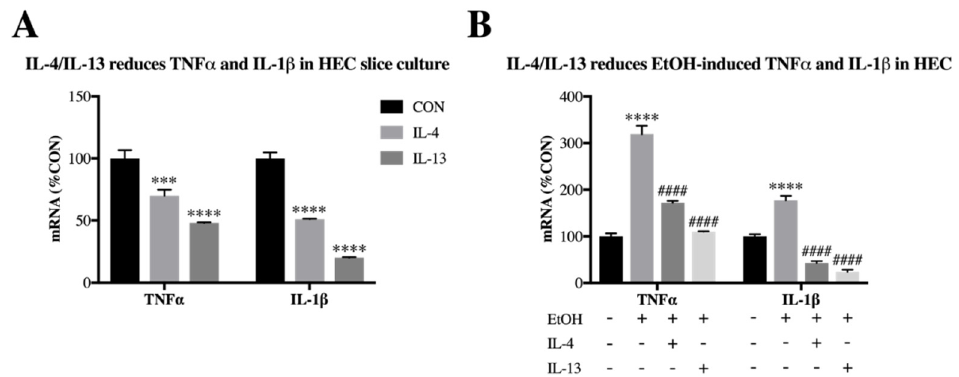
Figure 7. IL-4 and IL-13 reduce ethanol-induced TNF α and IL-1 β in hippocampal entorhinal (HEC) slice culture. Hippocampal entorhinal (HEC) slice cultures were exposed to either IL-4 (500 ng / mL), IL-13 (1 ug / mL), and / or EtOH (100 mM) for 48 h. Tissue was processed for mRNA expression. ( A ) TNF α expression was reduced by IL-4 (70 ± 5%) and IL-13 (48 ± 1%). IL-1 β expression was reduced by IL-4 (51 ± 1%) and IL-13 (20 ± 1%). ( B ) EtOH increased expression of TNF α (319 ± 18%), which was blocked by both IL-4 (172 ± 4%) and IL-13 (110 ± 1%). EtOH increased expression of IL-1 β (177 ± 9.8%), which was blocked by both IL-4 (43 ± 4%) and IL-13 (24 ± 4%). Data is represented as %CON (control), n = 12 slices in each well per group. *** p < 0.001, **** p < 0.0001 vs. CON; #### p < 0.0001 vs.